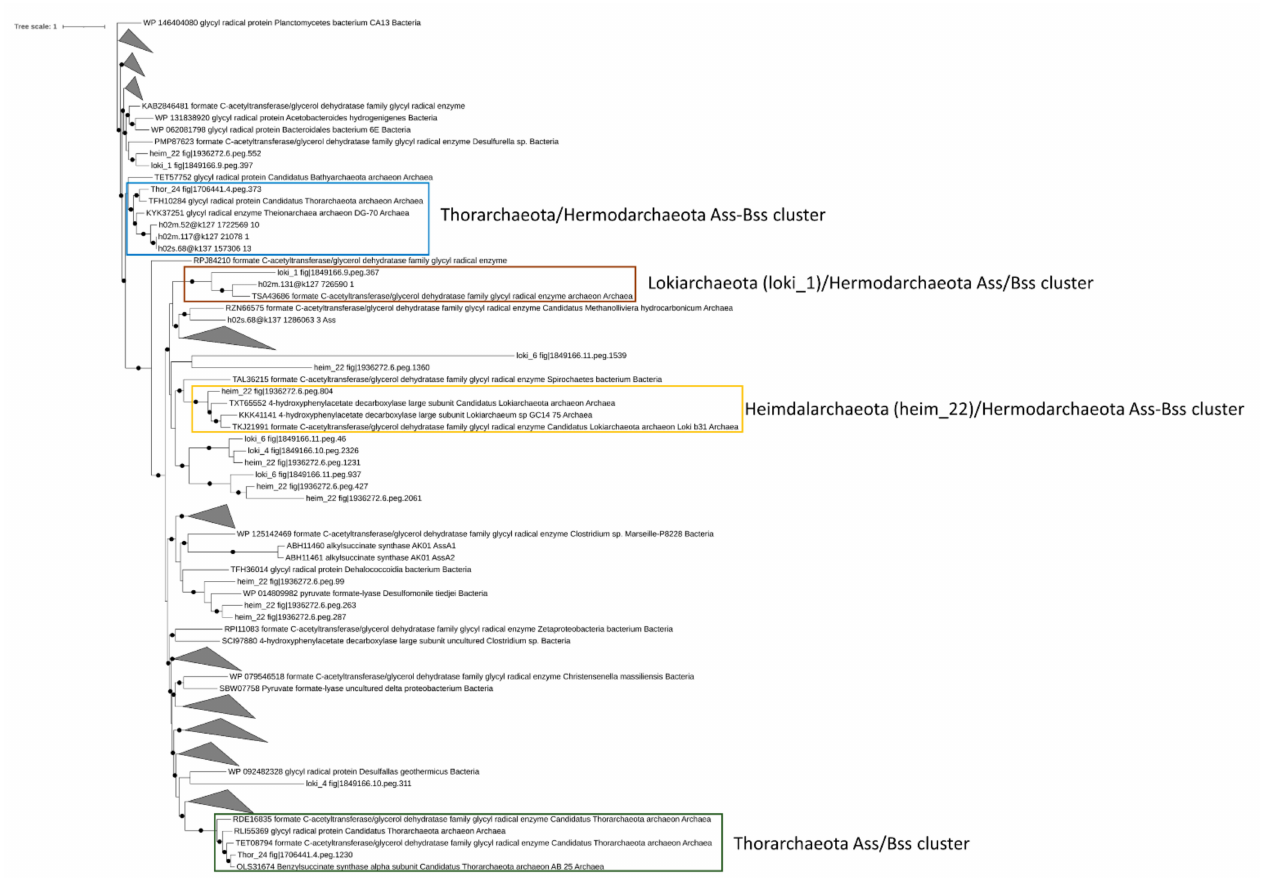
Figure 4. Phylogenetic tree of putative benzyl-alkyl-succinate synthase in Mar Piccolo Asgardarchaeota. Only nodes supporting a bootstrap value above 0.7 are shown. GenBank Accession numbers and Uniprot accession numbers are